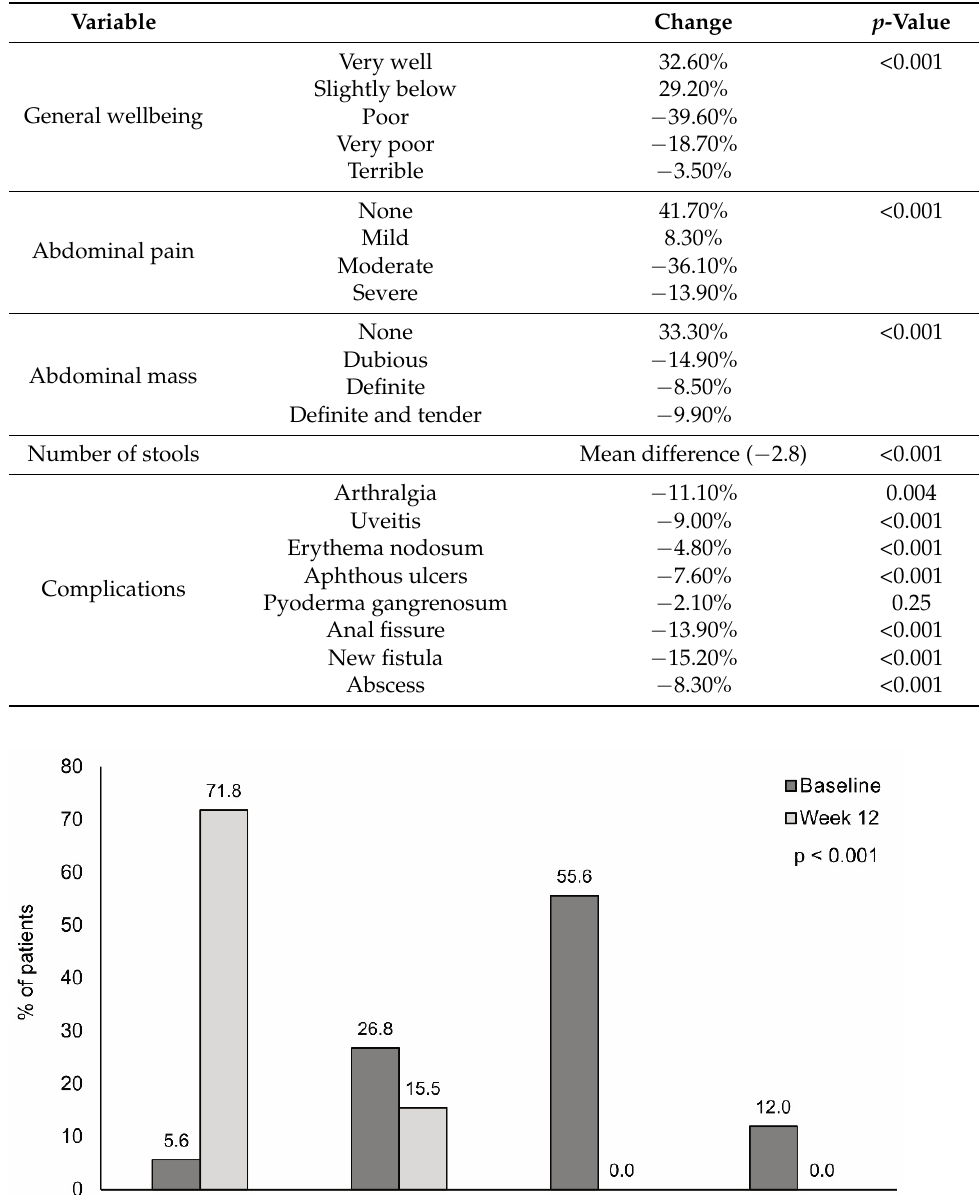
Table 2. Change in Harvey–Bradshaw index (HBI) score from baseline to week 12.